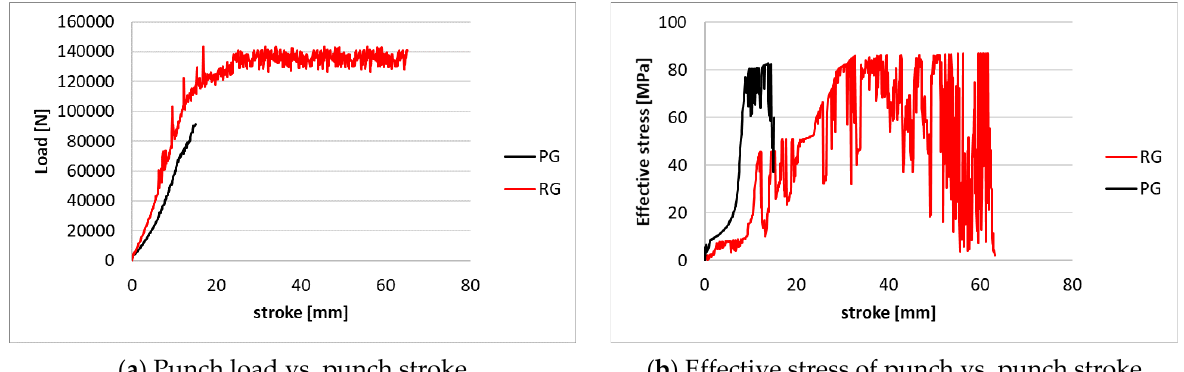
Figure 12. Load and stress punch analysis during deep drawing process.